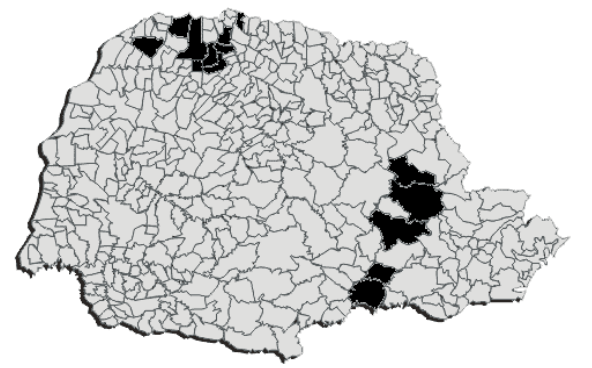
Figura 1. Mapa do Paraná destacando as cidades